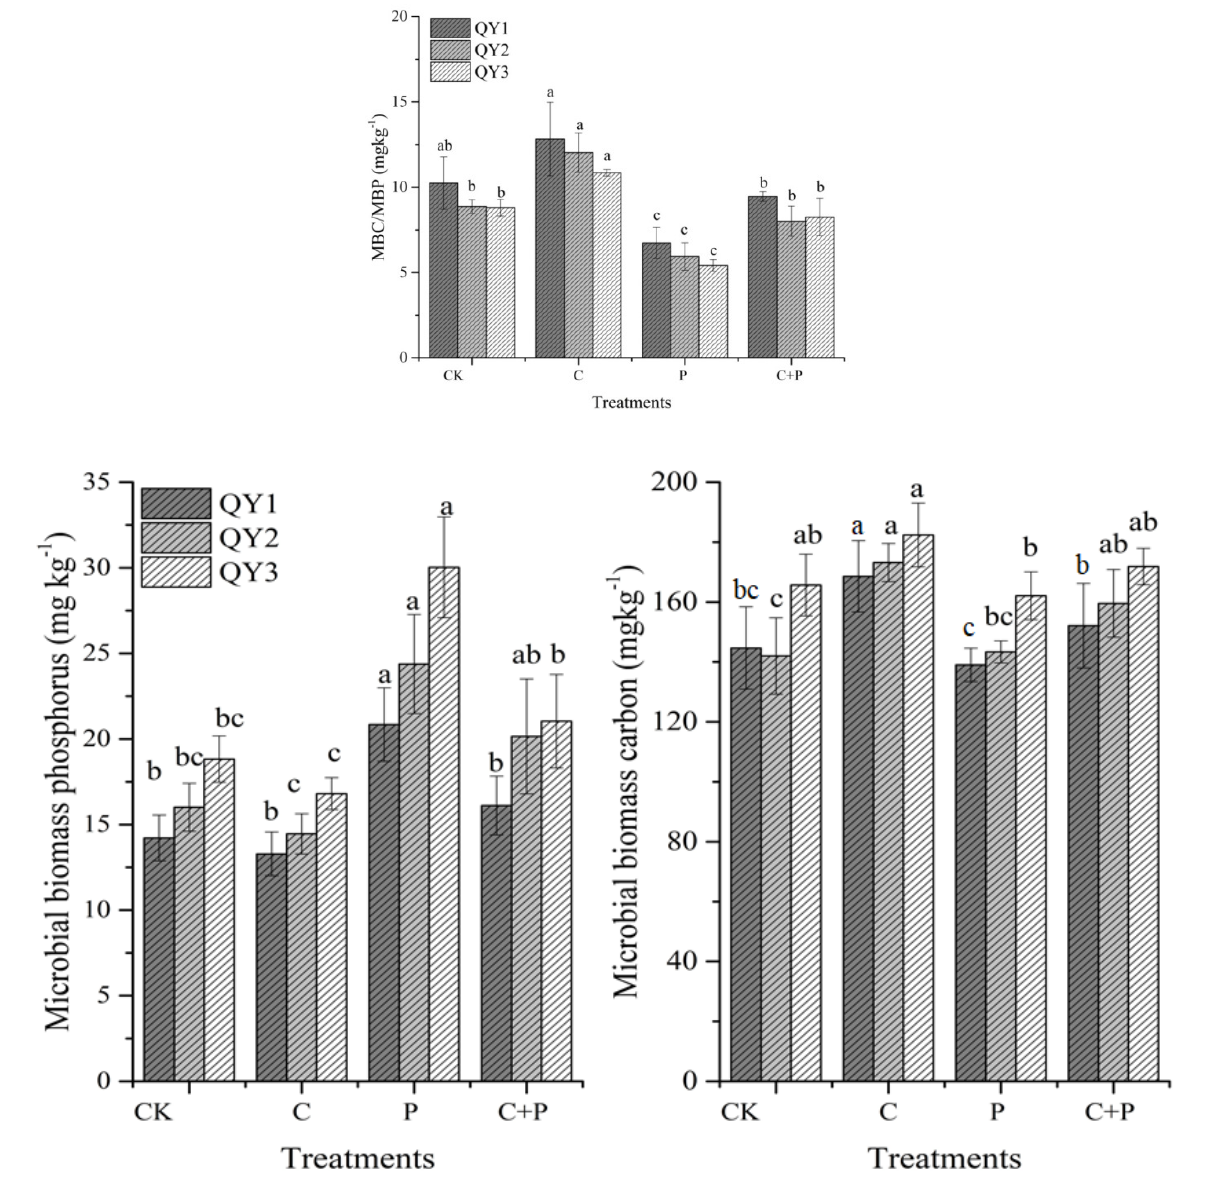
Figure 4. Soil microbial biomass carbon and phosphorus (MBC, MBP) concentrations in phosphorus-deficient (QY1) and phosphorus-adequate soils (QY2, QY3) with glucose and phosphorus addition during incubation period. CK: control; C, glucose addition; P, phosphorus addition; C + P, glucose and phosphorus addition. Different letters indicate significant differences between treatments of each soil type. Note: Phosphorus-deficient soil is represented by QY1 and soils with adequate phosphorus are denoted by QY2 and QY3.